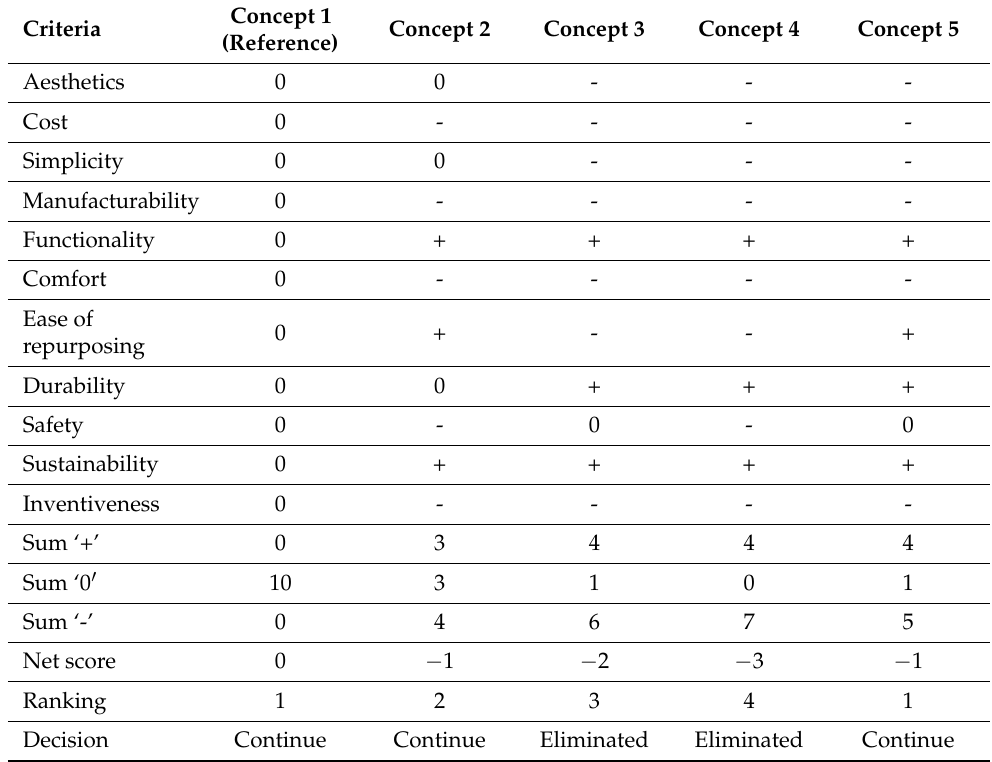
Table 4. Concept screening